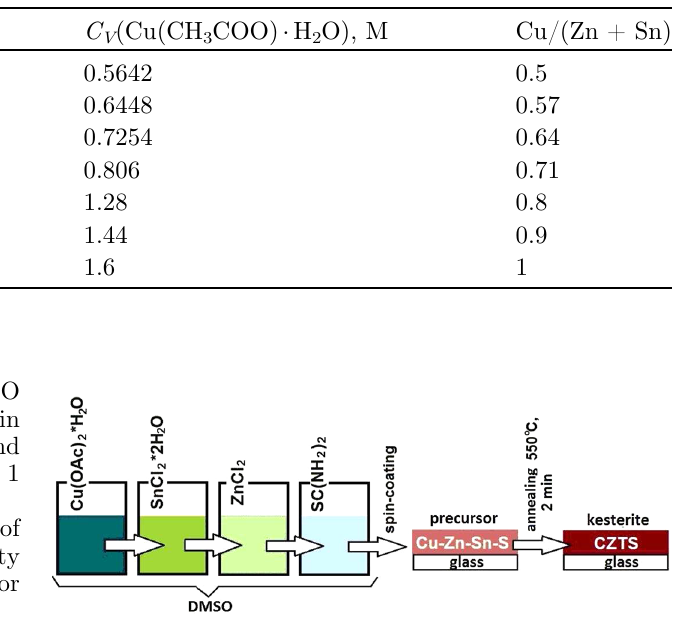
Fig. 1. The scheme of CBD synthesis method.